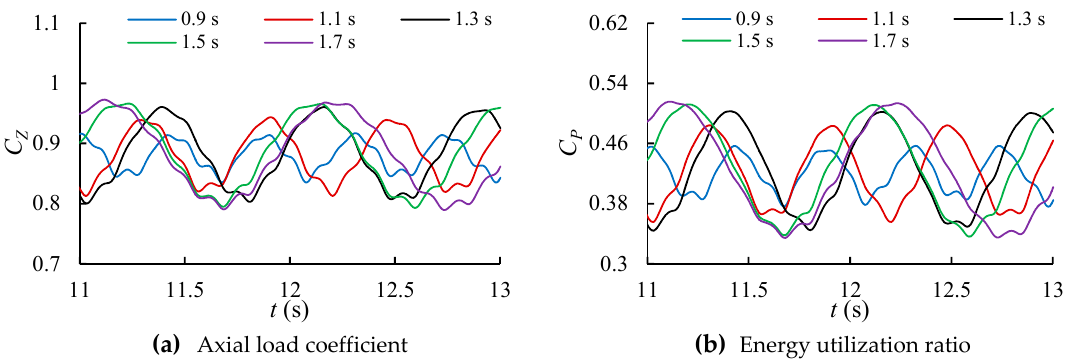
Figure 7. Time history curve under different wave periods.